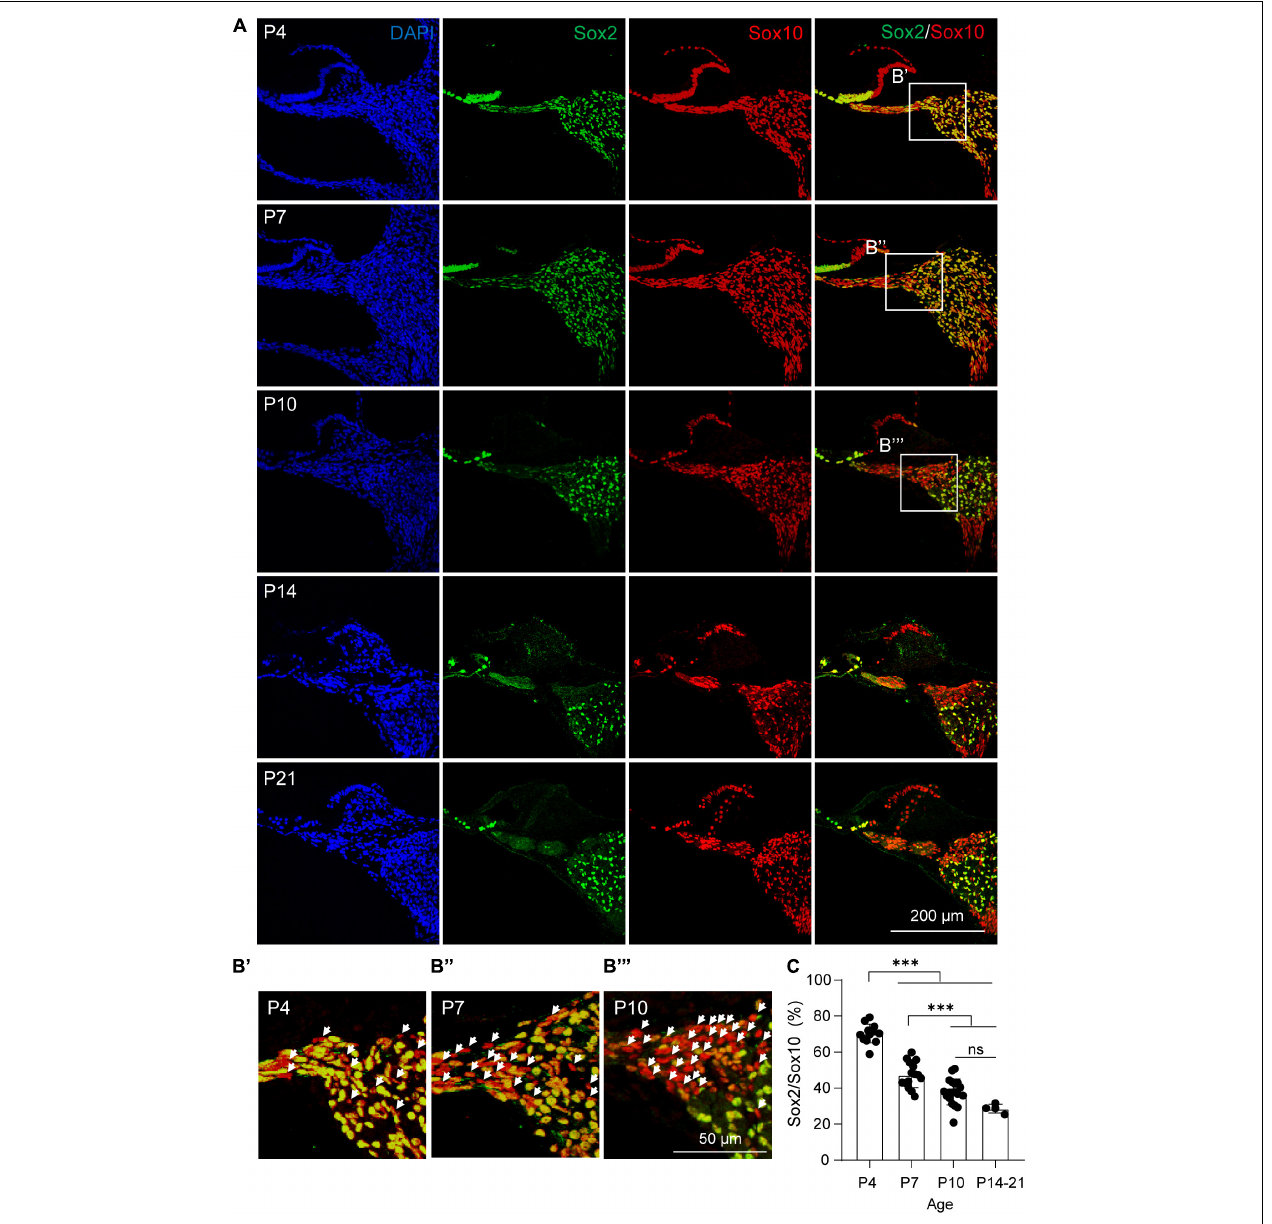
FIGURE 4 | Dynamic changes of Sox2 + cochlear glial cells during postnatal development. (A,B) Immunocytochemical staining of Sox2 and Sox10 from P4, P7, P10, P14, and P21 cochleae. The white arrow represents the Sox2 − /Sox10 + cell. (C) Percentages of Sox2 + /Sox10 + cells from P4, P7, P10, and P14 to P21 cochleae. N = 4–13 sections from 3 cochleae, error bars represent mean ± SD. *** p < 0.001 by one-way